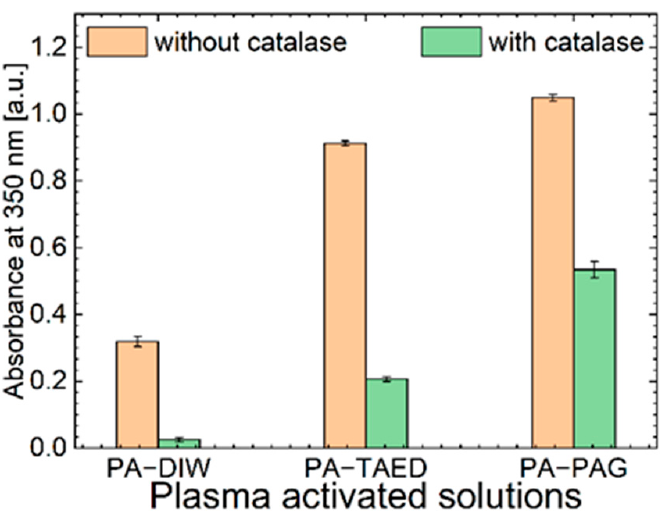
Figure 10. Oxidation of KI by PA-DIW, PA-TAED and PA-PAG with and without the presence of catalase.